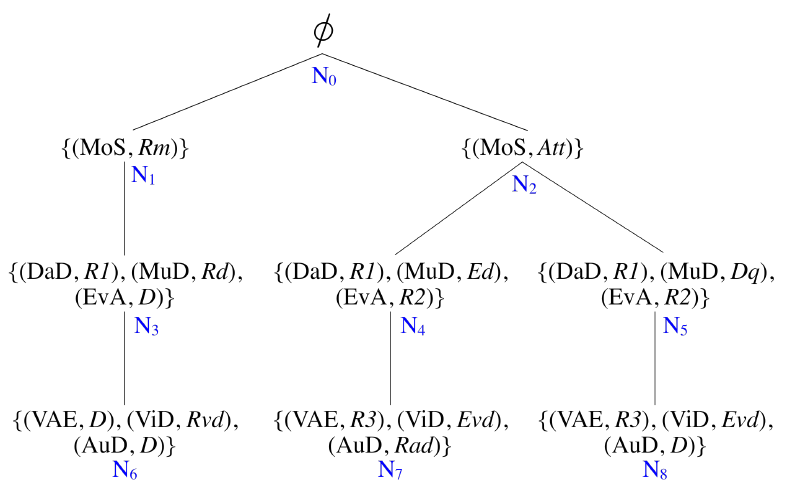
Figure 9. The mode combination tree of the monitoring subsystem.